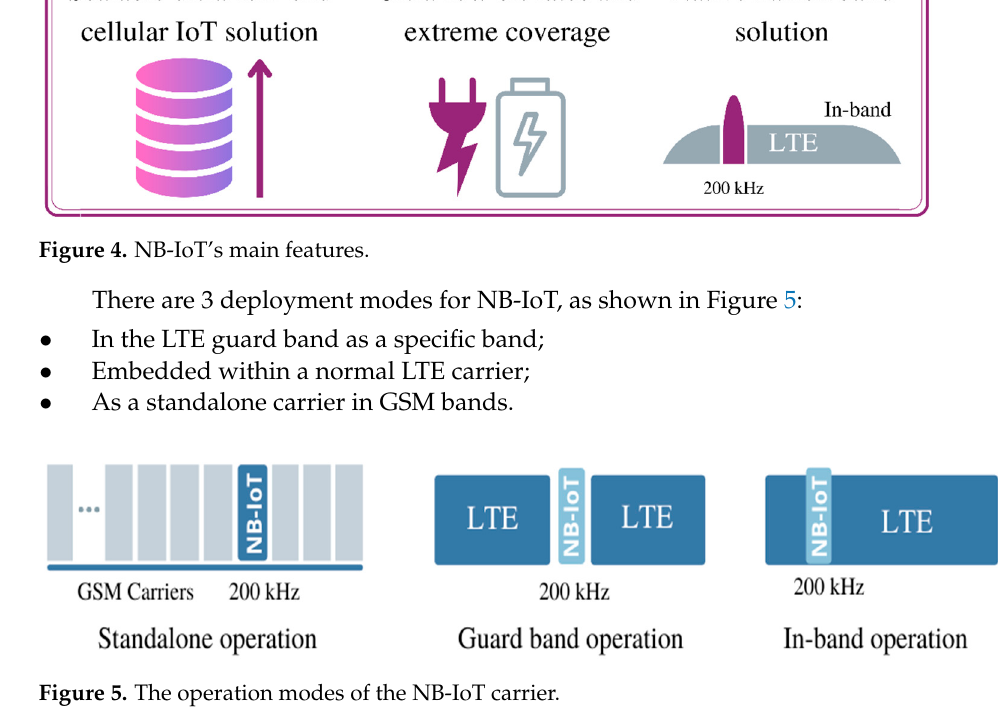
Figure 5. The operation modes of the NB-IoT carrier.